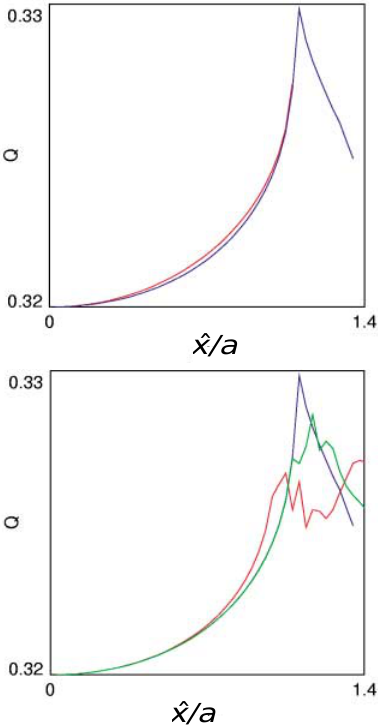
FIG. 13. (Color) (Top) Comparison of the nonlinear tune Q (cid:1) V (cid:1) 2 p (computed with a FFT) for the map M (red line) with ˆ j (cid:1) 0.05 , a ˆ K 0 (cid:1) 0.3 , v 0 (cid:1) 0.32 3 2 p , and the map M with 2 a space charge force approximated by a polynomial of order 5 FIG. 14. (Color) Numerical values (black line) and analytical (blue line). (Bottom) Comparison of nonlinear tune (computed estimates, obtained from the Hamiltonian H at order ; 3 (cid:1) 2 (red with a FFT) for the map M (blue line) with the tune obtained line) and order ; 2 (green line), of the area A x (cid:1) pe x of the stable from resonant normal form approximations of order 3 (red line) and 4 (green line). The horizontal coordinate is the linearly region, normalized to a 2 , for a pure sextupole with a ˆ K 2 (cid:1) 0.33 . normalized coordinate ˆ x divided by the core radius a . The area is plotted as a function of the linear tune Q 0 (cid:1) v 0 (cid:1) 2 p